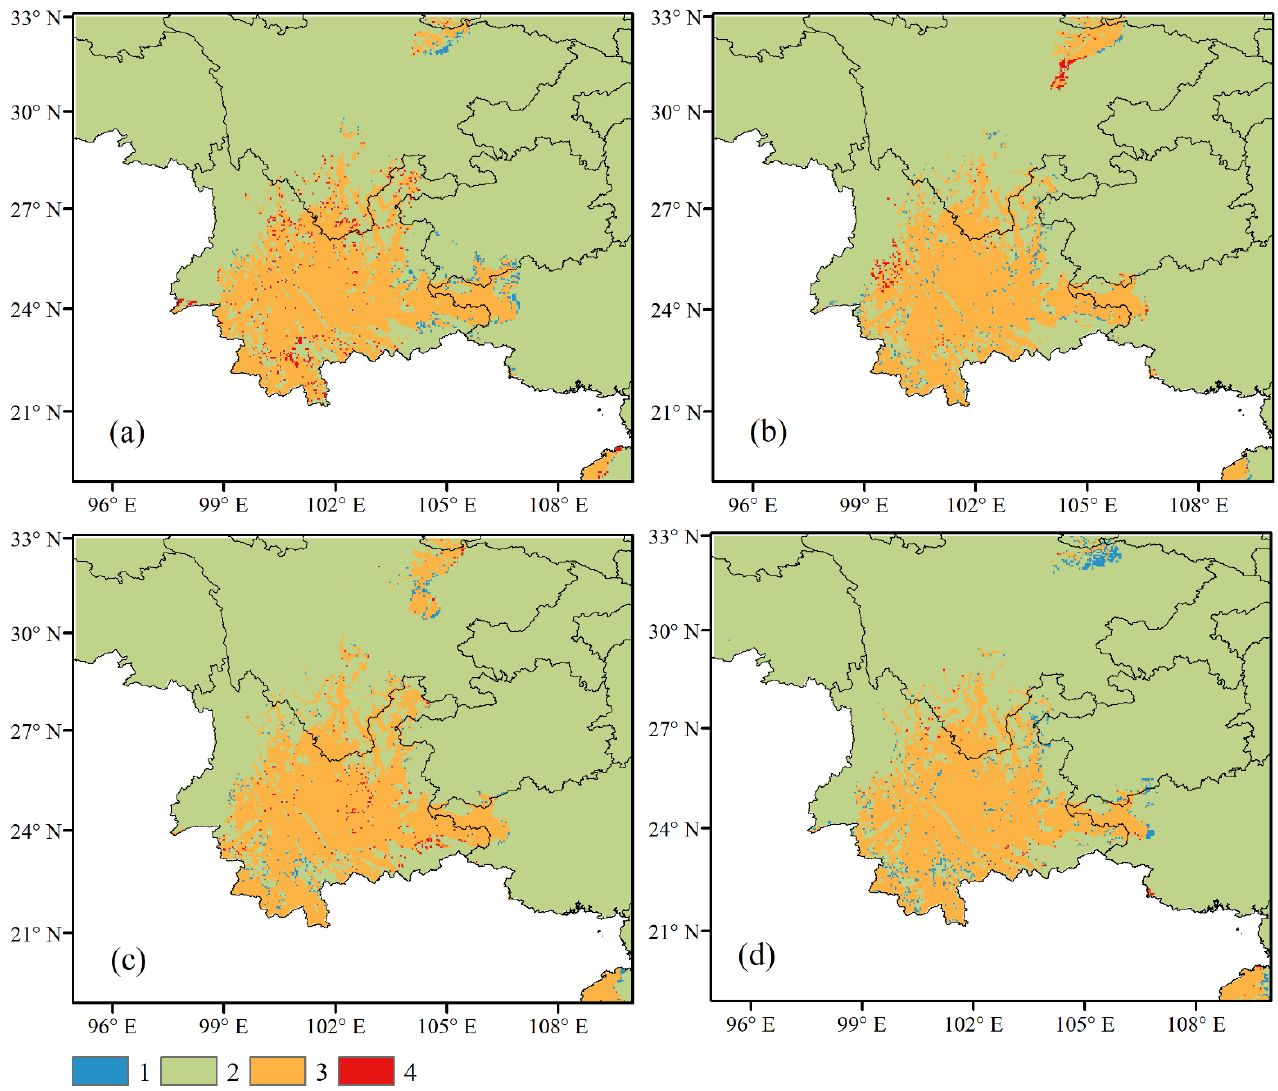
Figure 6. Changes in strictly extrapolative areas under future climate change of Garuga forrestii for ( a ) RCP4.5 scenario (2050), ( b ) RCP8.5 scenario (2050), ( c ) RCP4.5 scenario (2070) and ( d ) RCP8.5 scenario (2070). Colour shades indicate the level of agreement of strictly extrapolative areas. Blue shows areas extending outside the suitable areas, green denotes the unsuitable areas, orange indicates the suitable areas and red shows the areas lost in the suitable range.